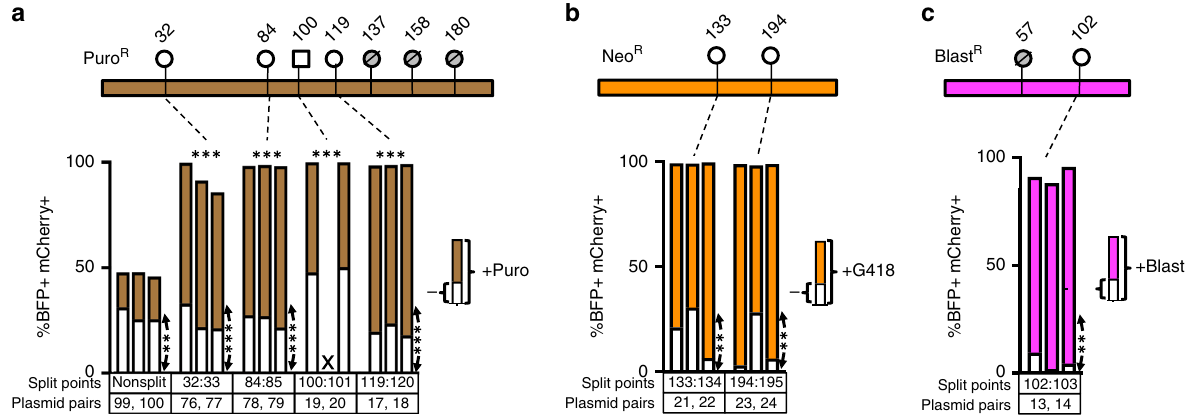
Fig. 3 Two-Split Puromycin, Neomycin and Blasticdin resistance genes. a 2-split Puromycin (Puro) Intres genes. Top schematics show split points tested for Puromycin resistance (Puro R ) genes while bottom column plot shows percentages of double transgenic cells in the non-selective (white portion) and the selective cultures (total column height = white + brown). Adjacent columns represent results from replicate experiments. X: No survival. b 2-split Neomycin/G418 (Neo) Intres genes. Top schematics show split points tested for Neomycin resistance (Neo R ) genes while the bottom column plot shows percentages of double transgenic cells in the non-selective (white portion) and the selective cultures (total column height = white + orange). Adjacent columns represent results from replicate experiments. c 2-split Blasticidin (Blast) Intres genes. Top schematics show split points tested for Blasticidin resistance (Blast R ) gene while bottom column plot shows percentages of double transgenic cells in the non-selective (white portion) and the selective (total column height = white + cyan) cultures. Results from triplicate experiments are shown as adjacent columns. Horizontal asterisks indicate statistical signi fi cance by one-way ANOVA test on the percentages of double-positive cells in the selected cultures of the speci fi c split marker vs those in the non- split marker (n.s., non-signi fi cant; * p < 0.05, ** p < 0.01, *** p < 0.001). Vertical asterisks indicate statistical signi fi cance by paired two-sided t -test on the percentages of double-positive cells in the selected cultures vs non-selected cultures within each transfection group (n.s., non-signi fi cant; * p < 0.05, ** p < 0.01, *** p < inteins (i.e., homogeneous intein), two using Npu DnaE for the fi rst intein and Ssp DnaB for the second intein, as well as two using Ssp DnaB for the fi rst intein and Npu DnaE for the second intein (i.e., heterogeneous “ orthogonal ” inteins) (Fig. 4d). The four heterogeneous-intein 3-split Hygromycin Intres enabled